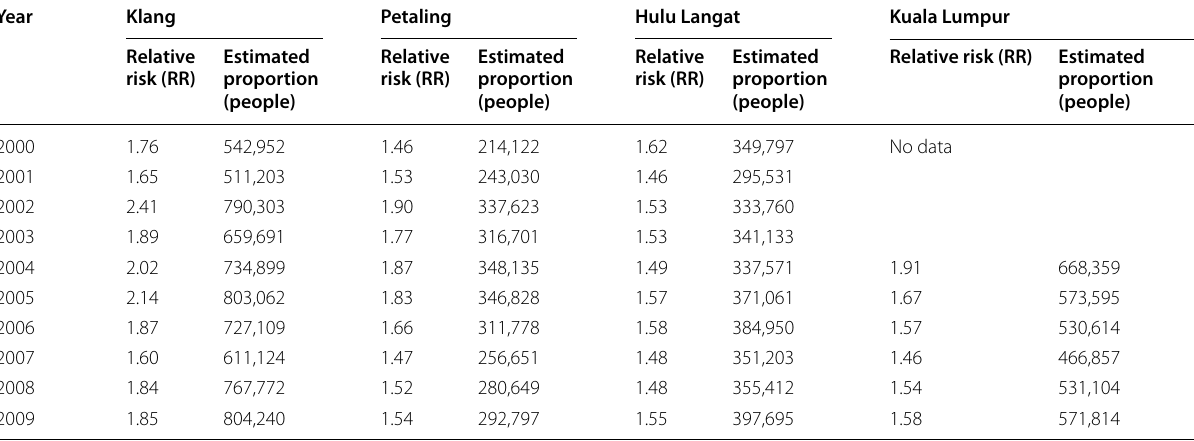
Gombak and Sepang districts are not included